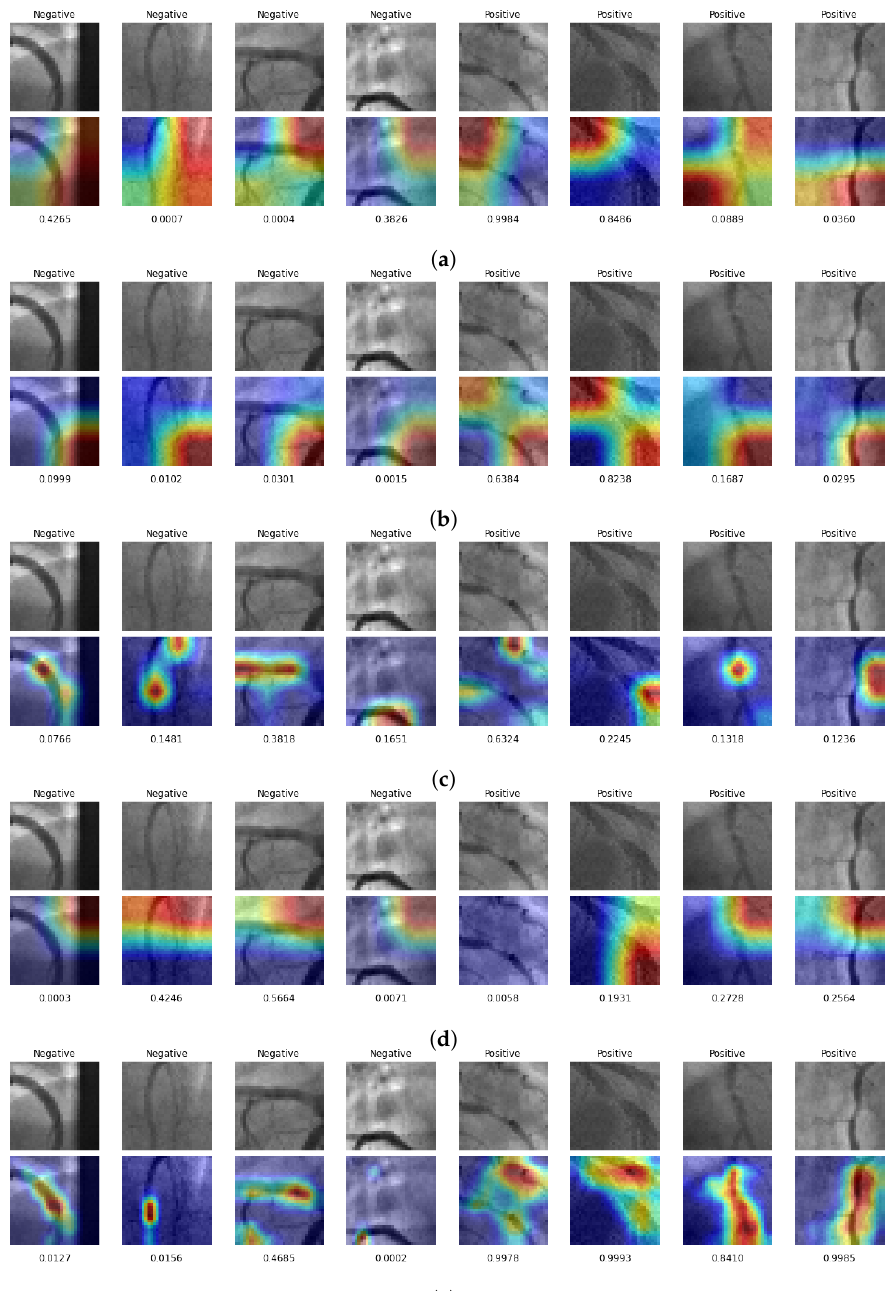
Figure 10. The GradCAM responses for the test subset of the A-DSSS dataset. Four negative and four positive stenosis cases are shown. ( a ) Vanilla ResNet18, ( b ) Vanilla SE-ResNet18, ( c ) Trim SE-ResNet18, ( d ) CBAM-ResNet34, and ( e ) Proposed LRSE-Net. Red tones stand for high-attention regions, and purple for low-attention ones. Bellow each image, the probability of stenosis is set. For values higher than 0.5, the models classify as stenosis